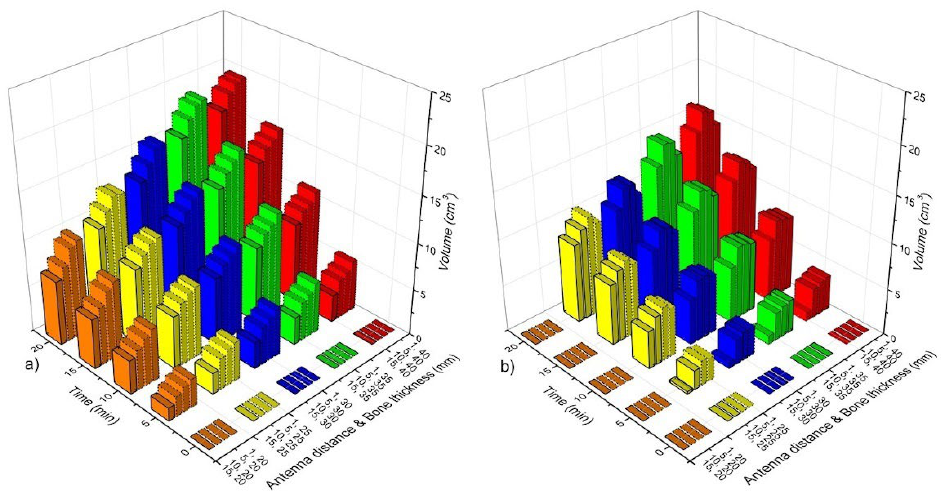
Figure 6. Bone tissue volume at ablation temperatures (T > 55 °C) as a function of time, antenna distance ( ad ), and bone thickness ( bt ). ( a ) Linear array of DS antennas, ( b ) linear array of MTM antennas.